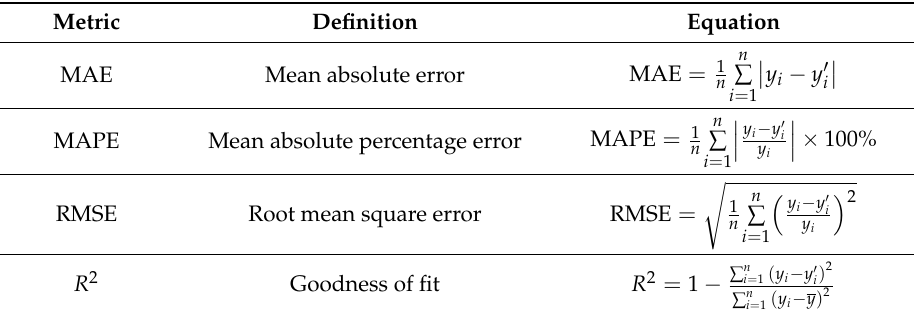
Table 2. Three metric rules for point